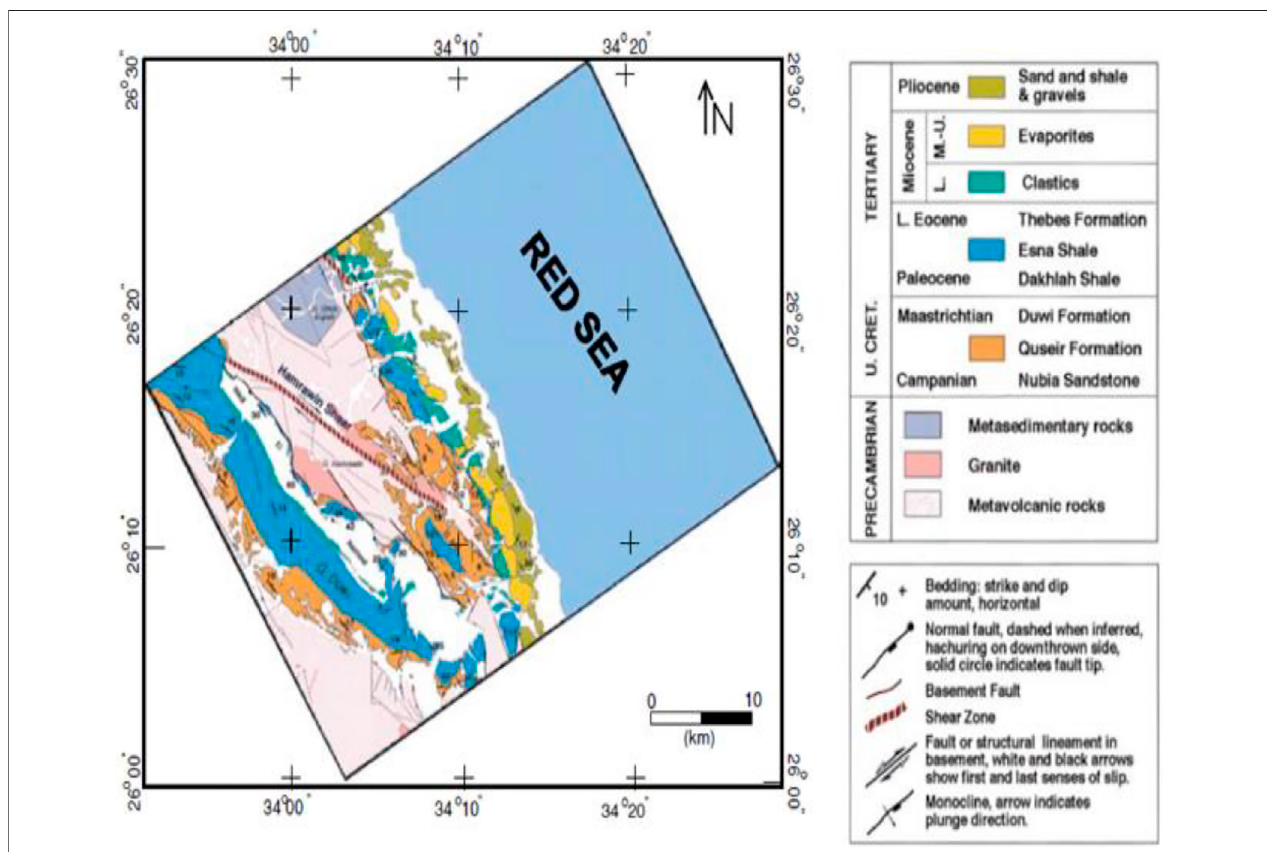
FIGURE 12 | Geologic map of the Quseir area, Egypt showing the Hamrawein shear (modi fi ed after Essa and Elhussein, 2018).